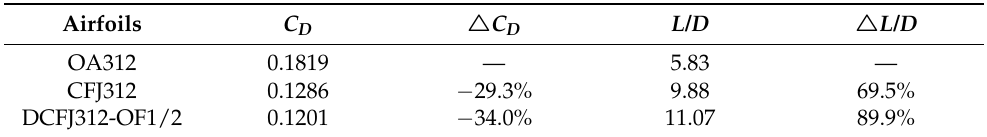
Table 5. Comparisons of drag coefficients and lift-to-drag ratios of DCFJ312 and CFJ312 airfoils at AoA = 20 ◦